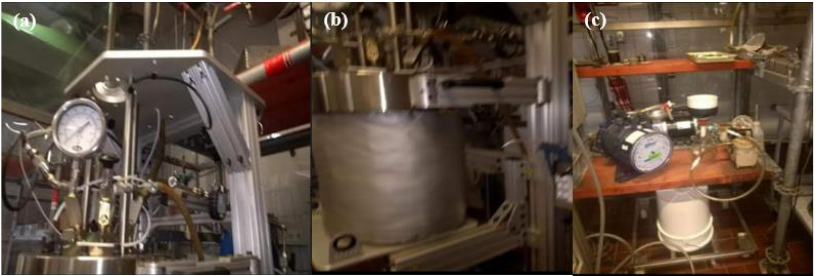
Figure 2. Pilot-scale stirred tank stainless steel reactor of 18.75 L (Parr, USA, Model: 4555) (Parr reactor: upper view ( a ); Parr reactor: frontal view ( b ); Degassing system ( c )).